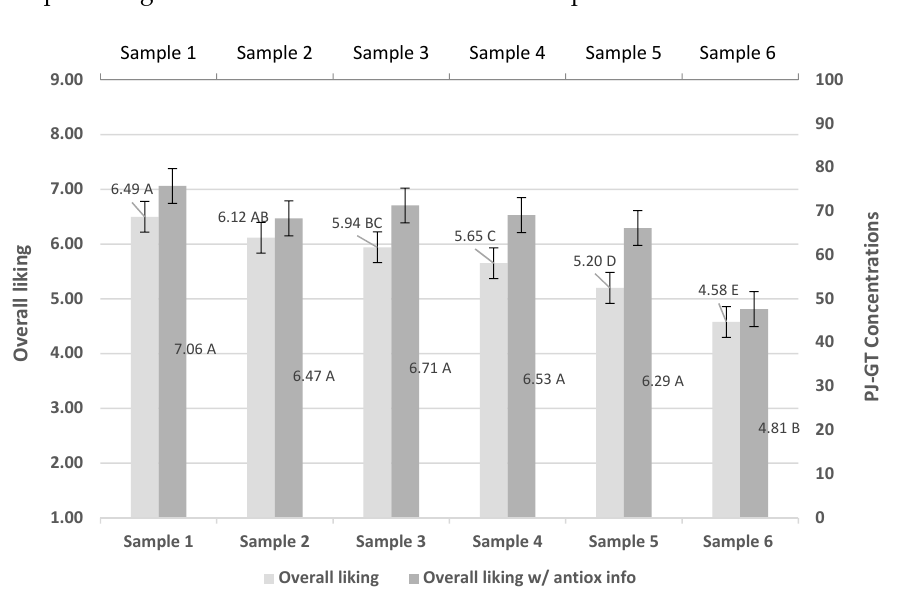
Figure 1. Mean scores for Overall Liking (scale 1: dislike extremely, 9: like extremely), evaluated before ( n = 100) and after ( n = 16 for samples 40:60 and 90:10 and n = 17 for samples 80:20, 70:30, 60:40, and 50:50) the antioxidant information was provided, compared to the samples’ PJ and GT content (scale on the right 0–100%). The samples with different letters were significantly different ( p < 0.05) following Fisher’s LSD significant differences.